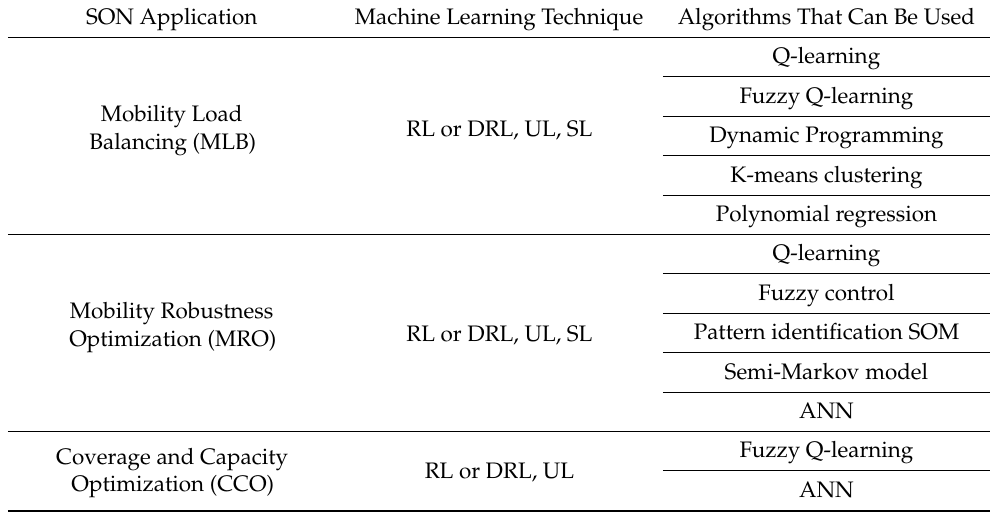
Table 2. ML technique and possible algorithm used per SON